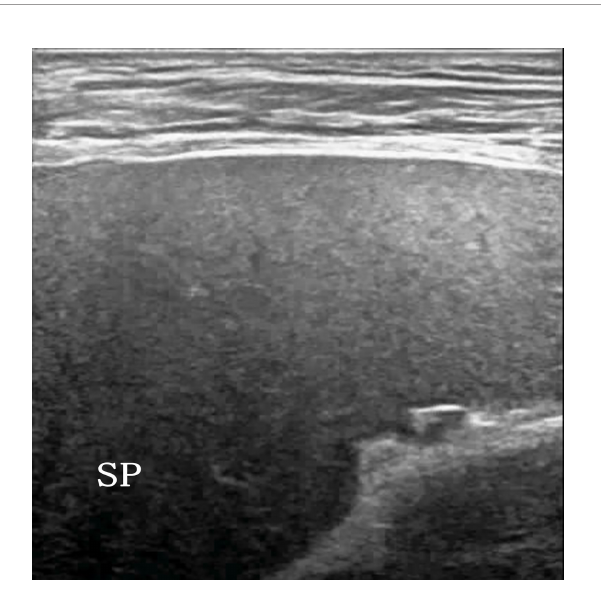
FIGURE 2 | A 54-year-old man clinically suspected of having splenic lymphoma. Two-dimensional ultrasound (2D US) showed uniform splenic